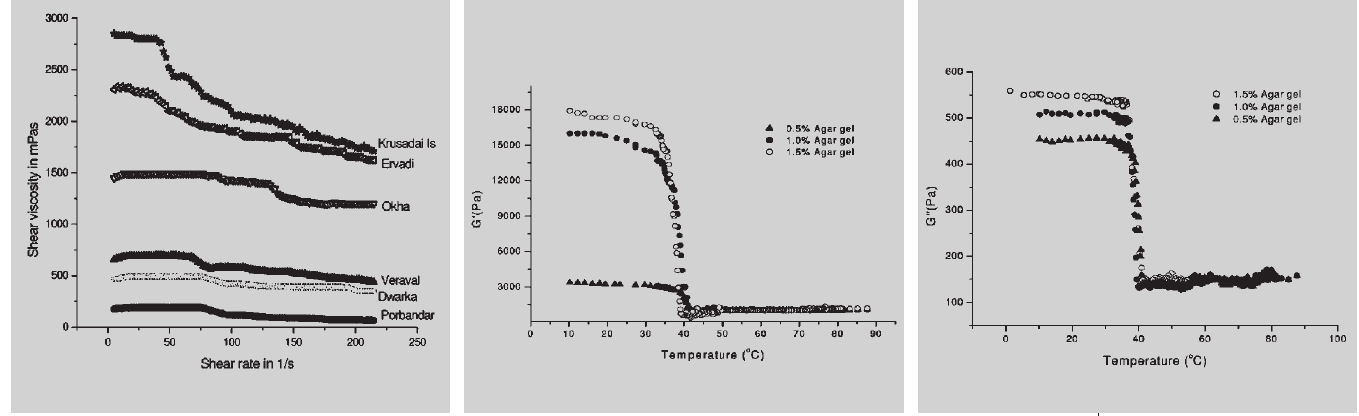
Figure 1 (left): Gel thinning behaviour of various agar gels (1.5% gel) obtained from Gelidiella acerosa collected from dif- ferent places at 45˚C. Figure 2a (middle): Temperature dependency of G’ of various agar gels (con- trolled deformation mode, strain 0.05%, frequency 1 Hz, cooling rate 1˚C/min, cone/plate geometry). Figure 2b (right): Temperature dependency of G’’ of various agar gels (con- trolled deformation mode, Strain 0.05%, frequency 1 Hz, cooling rate 1˚C/min, cone/plate